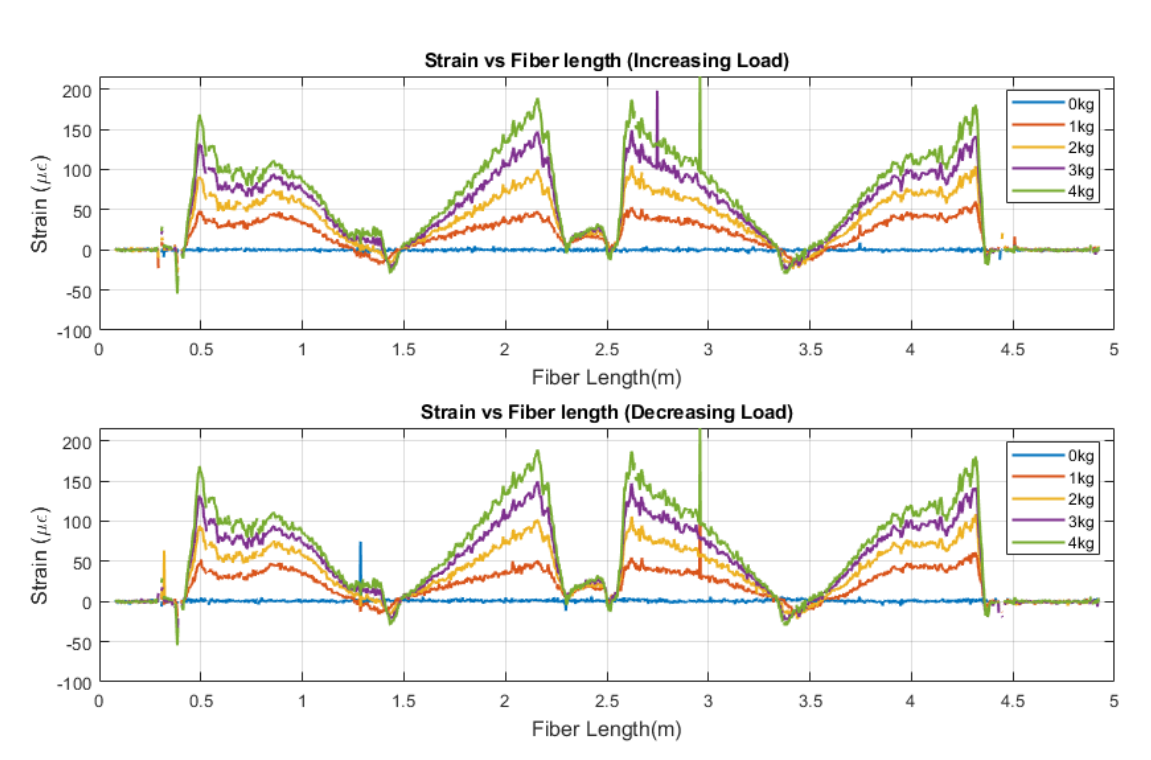
Figure 3. Distributed strain response along the entire fiber